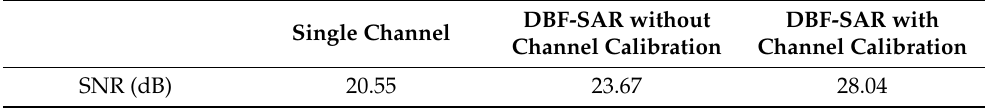
Table 6. SNR of single channel, DBF-SAR without channel calibration and DBF-SAR with channel calibration.